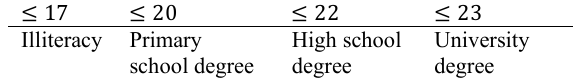
Table 1 Diagnostic criteria for MMSE